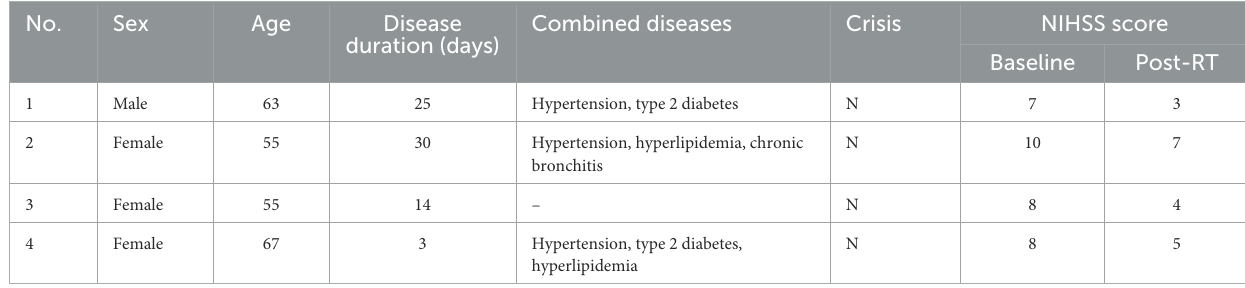
TABLE 3 Protein concentration measurements in ischemic stroke before (CI, n = 4) and after rehabilitation treatment (RT, n = 4).